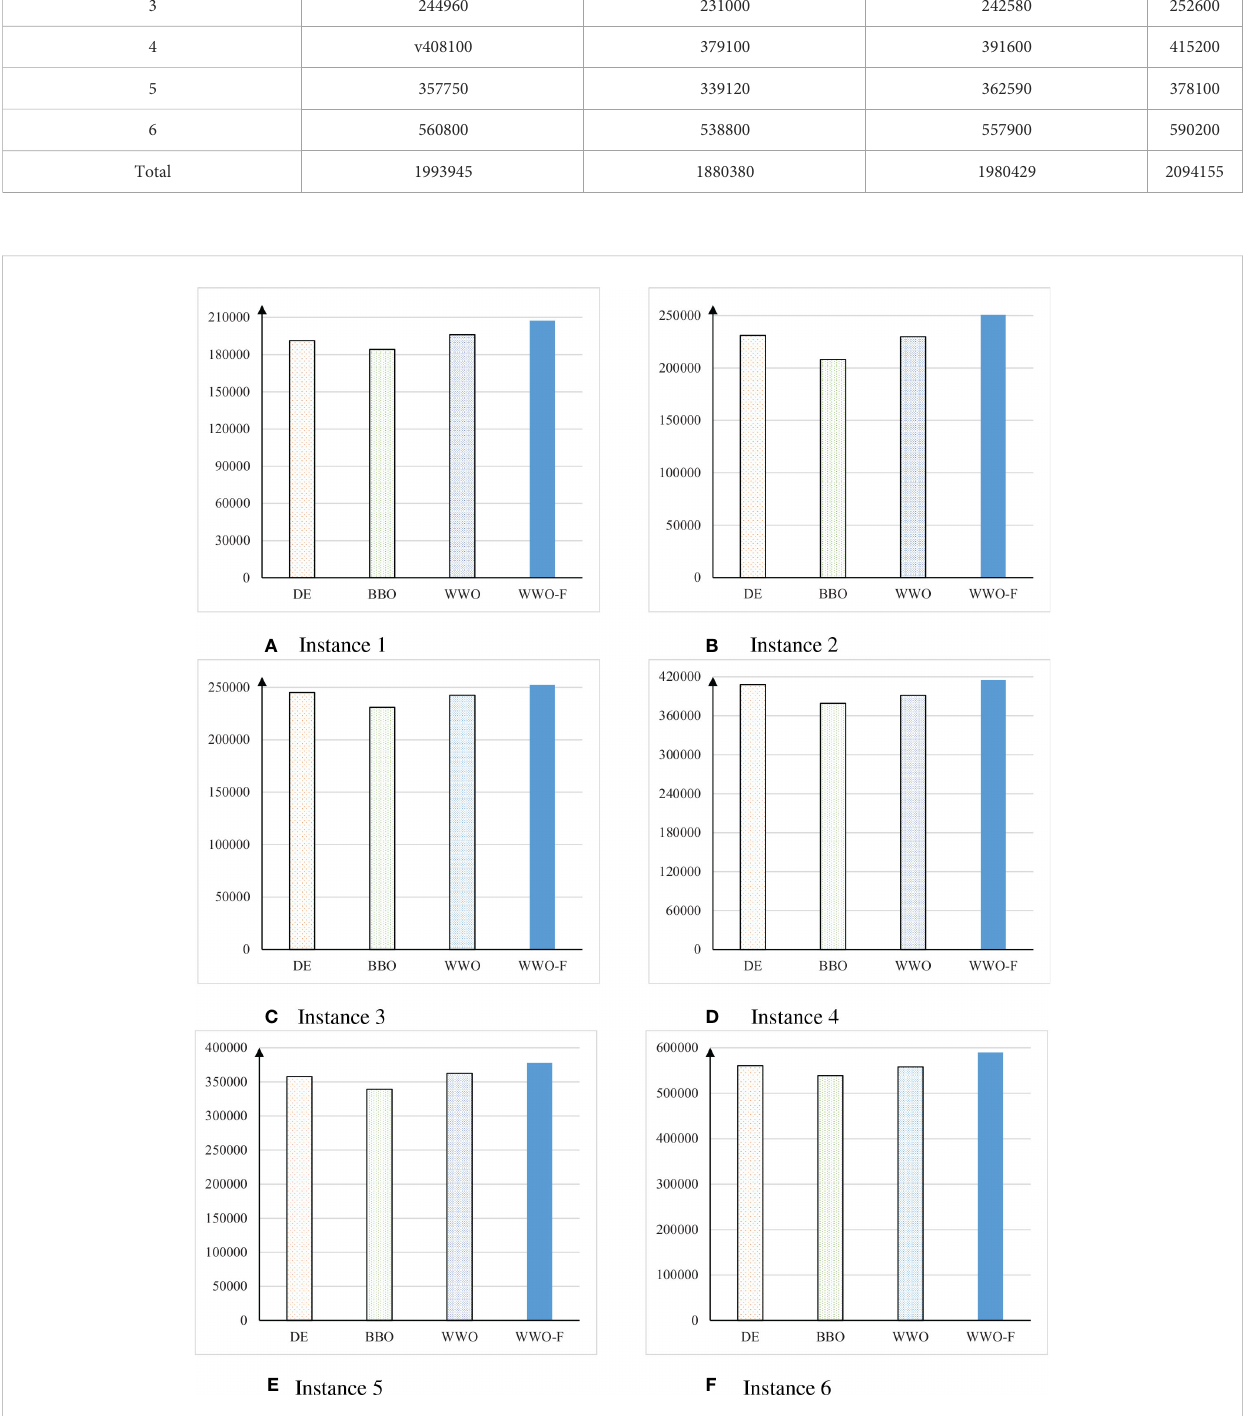
FIGURE 2 Comparison of the pro fi ts of the solutions obtained by the three non-fuzzy evolutionary algorithms and the proposed WWO with fuzzy optimization (WWO-F) on the six test instances (A – F)